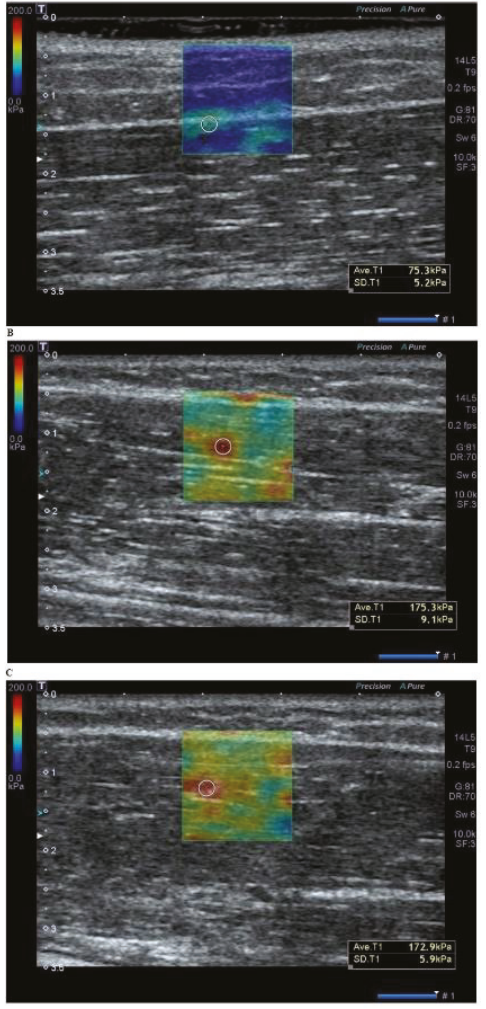
Figure 1. A shear wave elastography of the trapezius muscle at baseline. ( A ) No increased stiffness is seen in the asymptomatic muscle. ( B ) Increased stiffness at the myofascial trigger point is seen within the region of interest (ROI) in the posterior neck. ( C ) Increased stiffness is seen as a band form, not at the single location within the ROI.